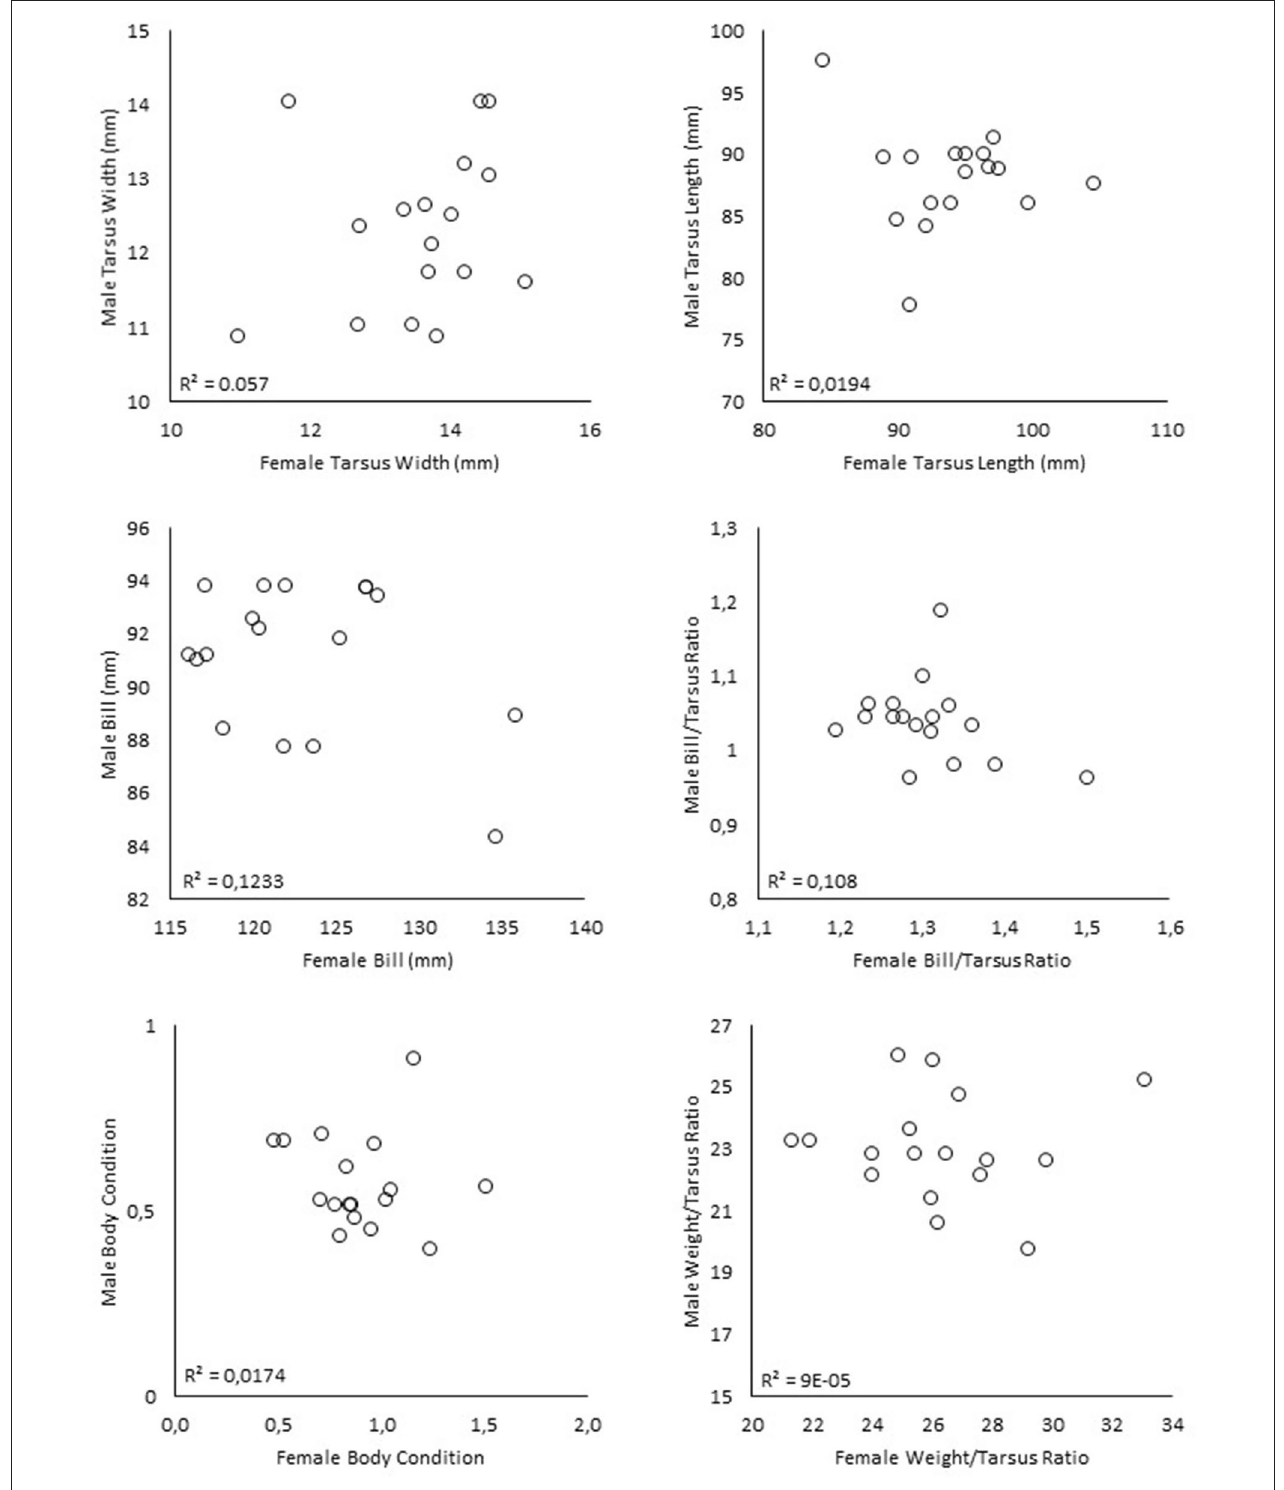
FIGURE 3 | Correlations between morphometric measurements of paired male and female A. mantelli from Ponui Island. The unit of weight is grams. Bill, tarsus length, and tarsus width are given in millimetres. Body condition is based on a combination of weight and tarsus width (Taborsky and Taborsky, 1999). None of the correlations were found to be significant. R 2 values refer to linear